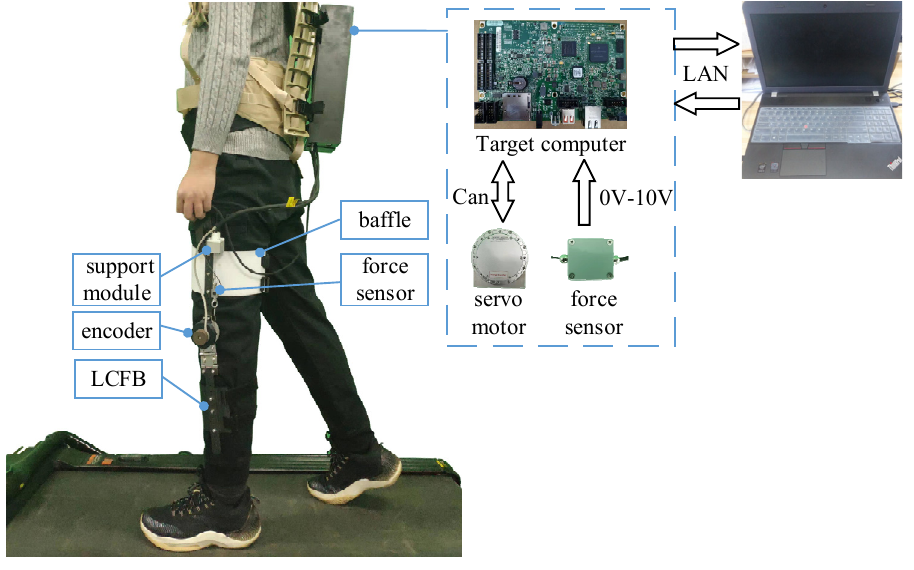
Figure 8. The designed knee joint exoskeleton.